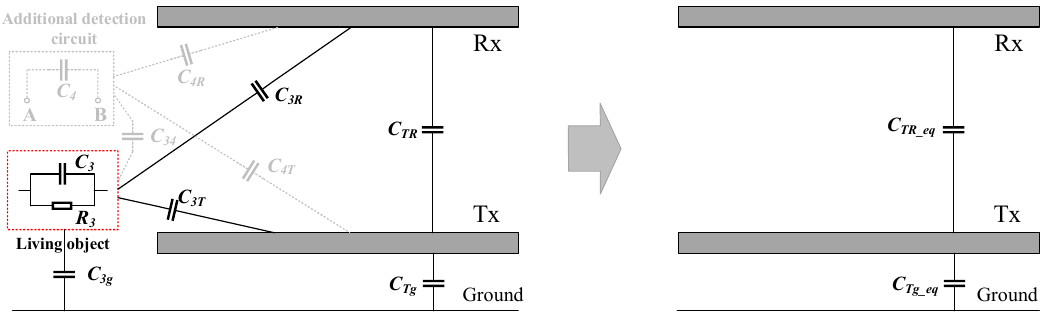
Figure 12. Equivalent circuit of the drain waveform detection method.